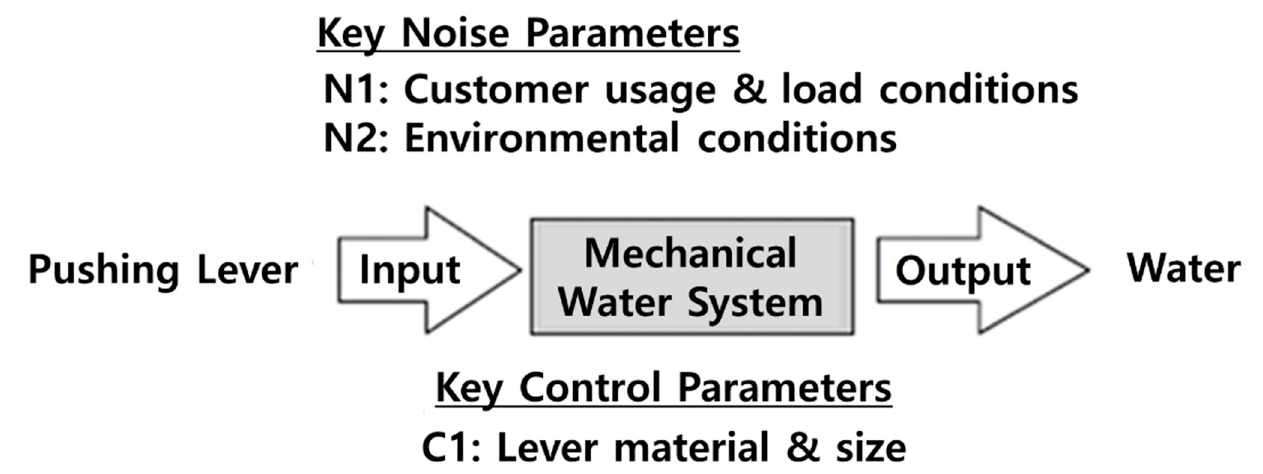
Figure 4. Parameter representation of the water dispenser (instance).